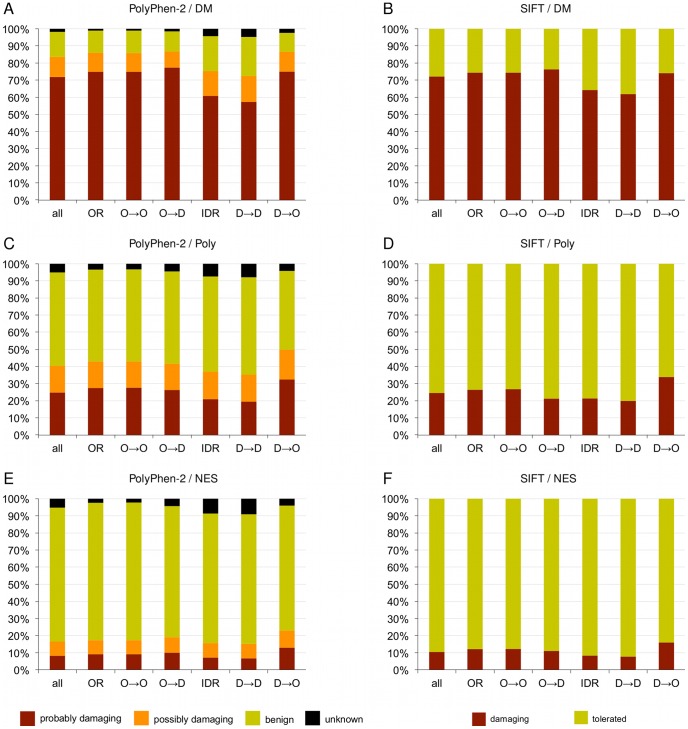
Distribution of PolyPhen-2 (panels A, C, E) and SIFT (panels B, D, F) calls for mutations in DM, Poly and NES datasets.Both predictors show a drop in sensitivity for disease mutations in IDR and D→D categories (A, B) and a drop in specificity for D→O mutations in Poly (C, D) and NES (E, F).